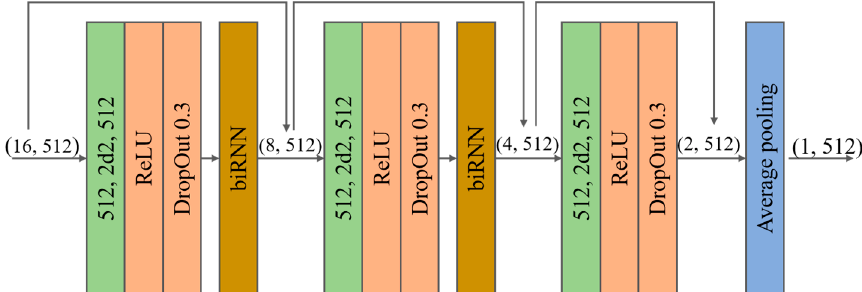
Figure 4. Overview of the temporal convolutional encoder. The output has 16 frames, and the feature dimension has 512. The convolutional layer is shown in green, where (512, 2d2, and 512) represents 512 input channels, a convolution kernel size of two, and a stride of 2512 output channels. Finally, average pooling produces the feature vector from a single frame.